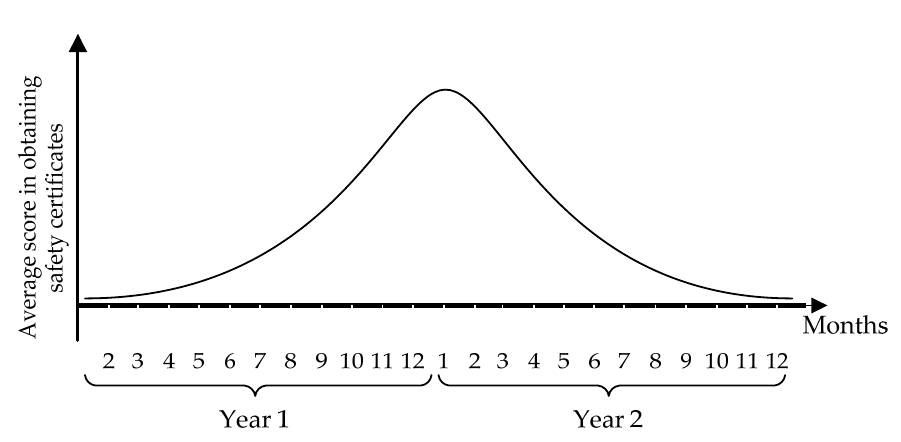
Figure 7. Association between the LSC and the certificate renewal period.